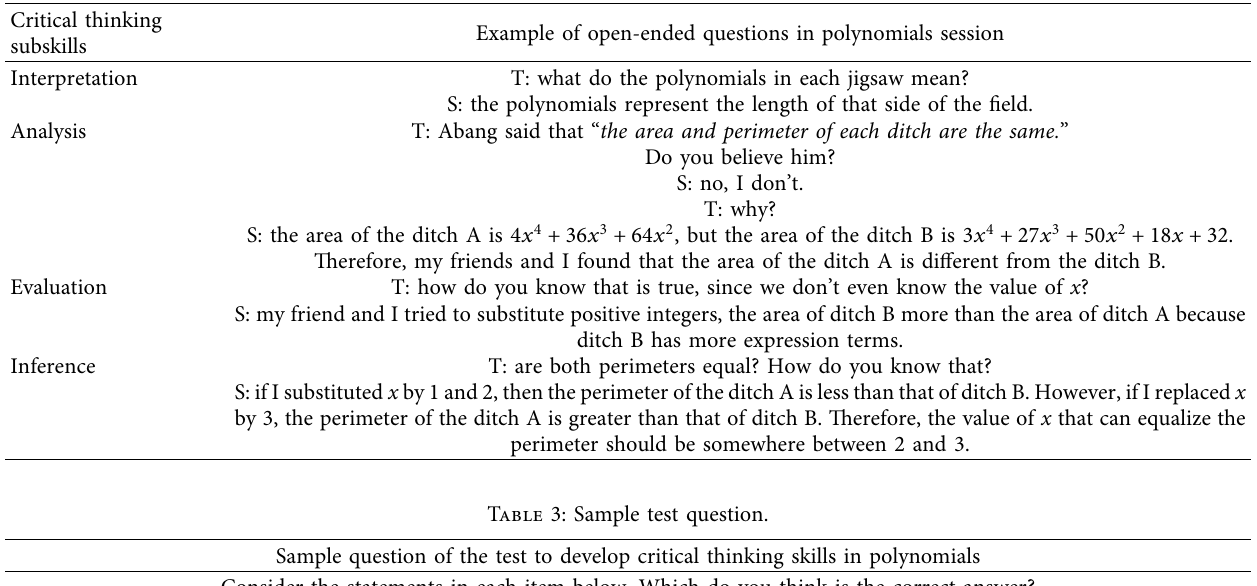
Table 2: Use of open-ended questions in intervention.